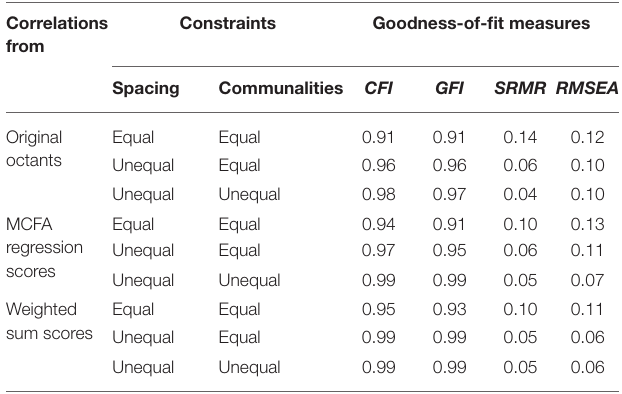
TABLE 1 | CircE results of the inventory of interpersonal problems for original and reproduced correlations of the octant scales. Correlations Constraints Goodness-of-fit measures from